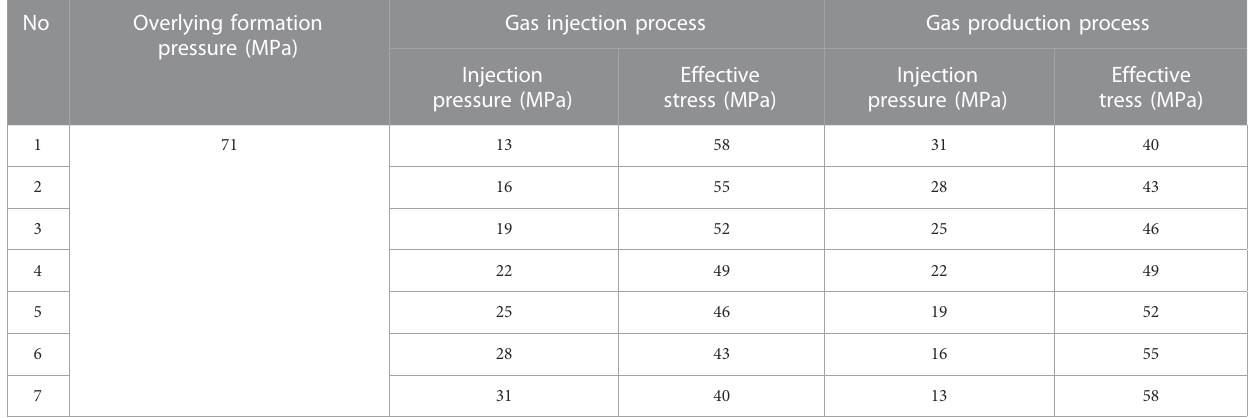
TABLE 1 Table of injection pressure and effective stress for periodic injection and production of X